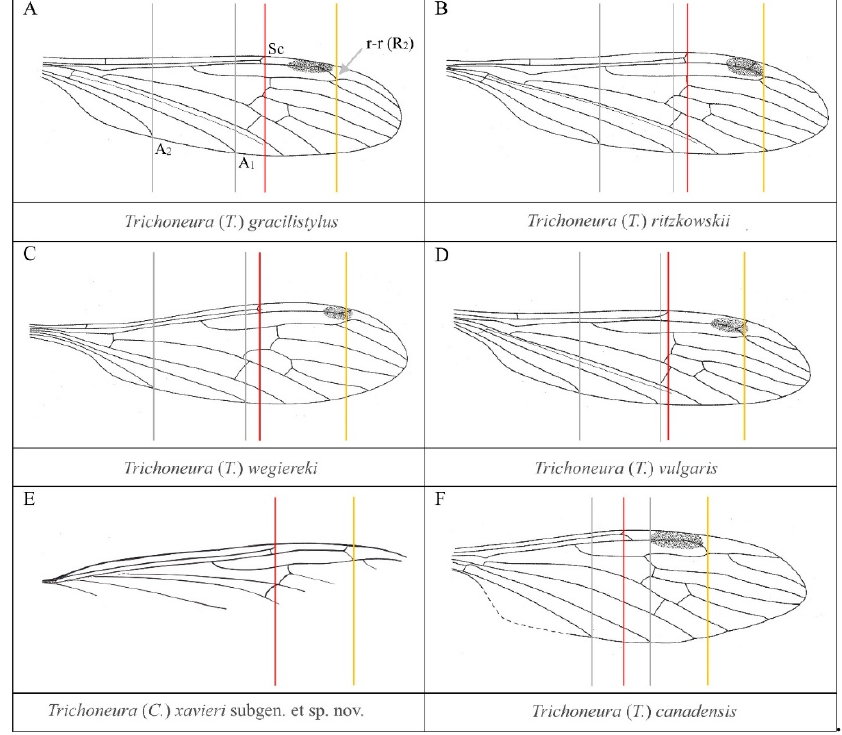
Figure 5. Wing venation of extinct species of the genus Trichoneura. Abbreviation: vertical lines indicate the line ends – grey lines tips of A 1 and A 2 ; red line, tip of Sc; yellow tip of R 1 . The drawings are redrawn after [1,6–9].